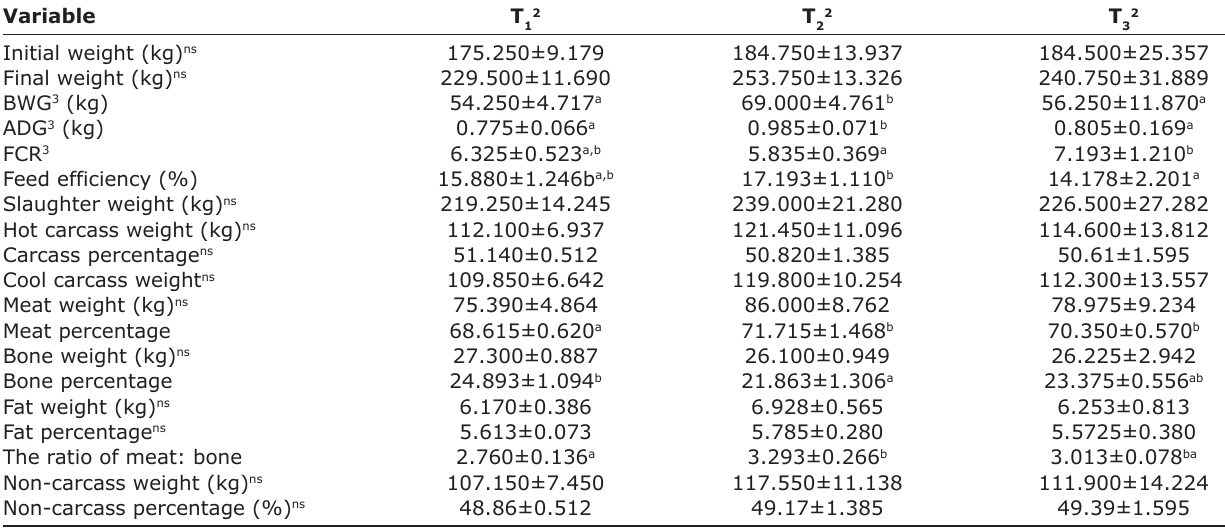
Table-4: Carcass characteristics of male Bali cattle fattened by complete feed which protein contains Gliricidia sepium leaves 1 Variable